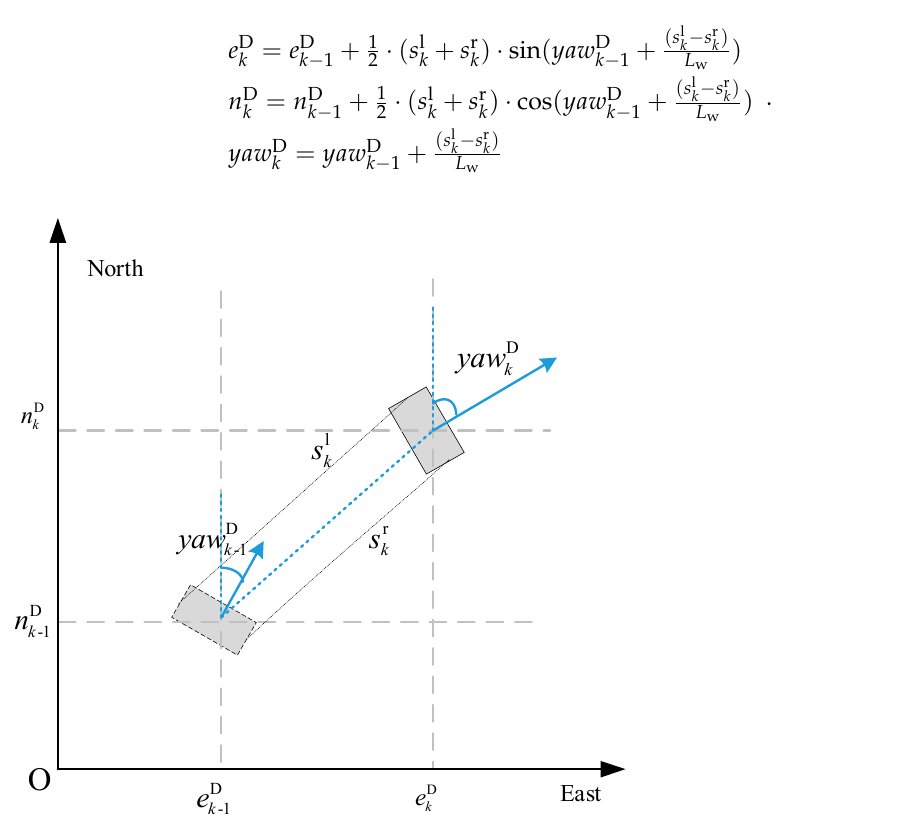
) is the increment of the left and right wheels in ∆ t D , ( L where ( o l , o r k − 1, k k − 1, k maximum count per rotation of the left or right wheel, W r is the radius of the wheel, and L w is the distance between the two wheels. Therefore, the navigation coordinate ( e D and yaw angle yaw D at time k in the DDE system model is k